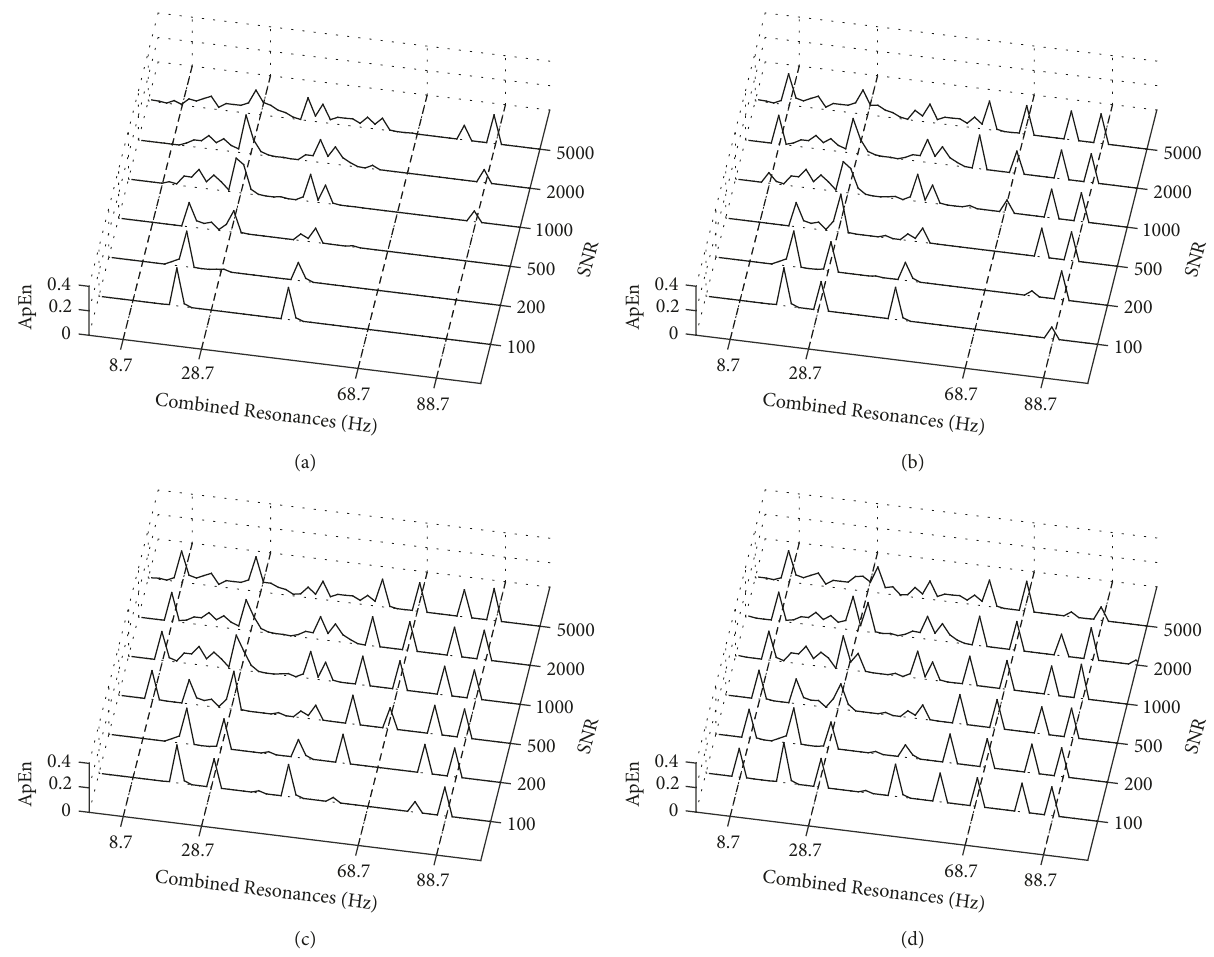
Figure 12: Approximated Entropy for different levels of SNR in the FFTs: (a) 1% crack depth; (b) 3% crack depth; (c) 5% crack depth; (d) 10% crack